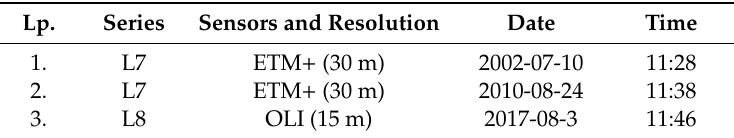
Table 2. Satellite images used in true color and Normalized Difference Vegetation Index (NDVI) interpretations.